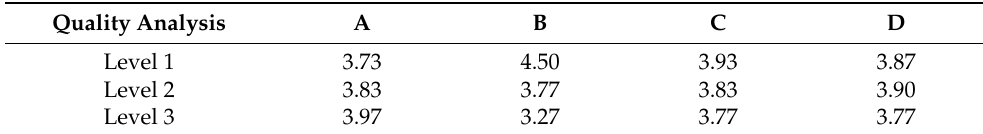
Table 5. Average of factors at three levels.